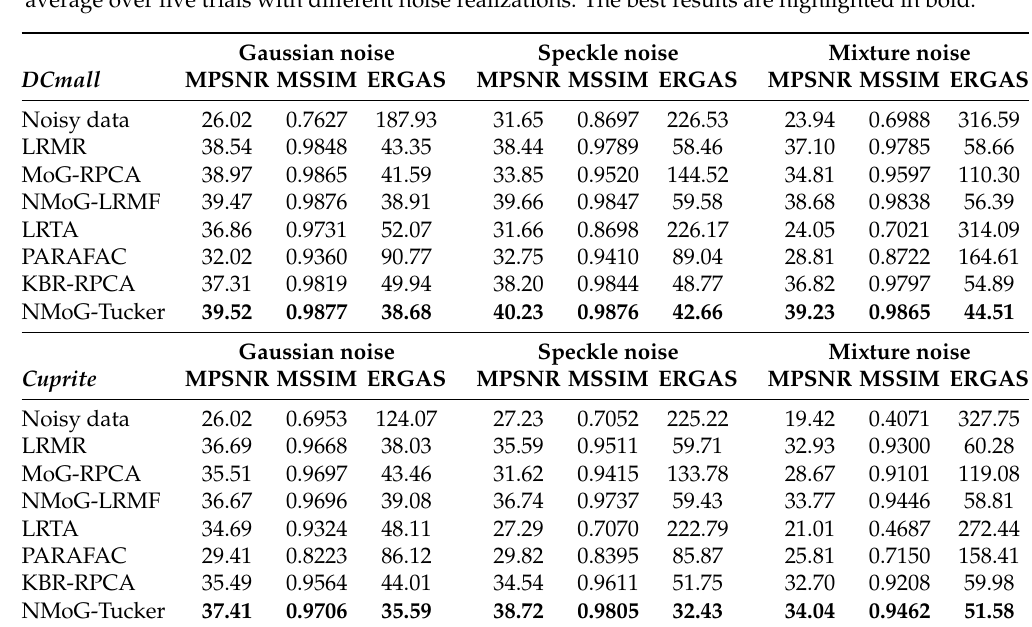
Table 4. Quantitative performance of different methods on simulated HSI denoising. Every result is an average over five trials with different noise realizations. The best results are highlighted in